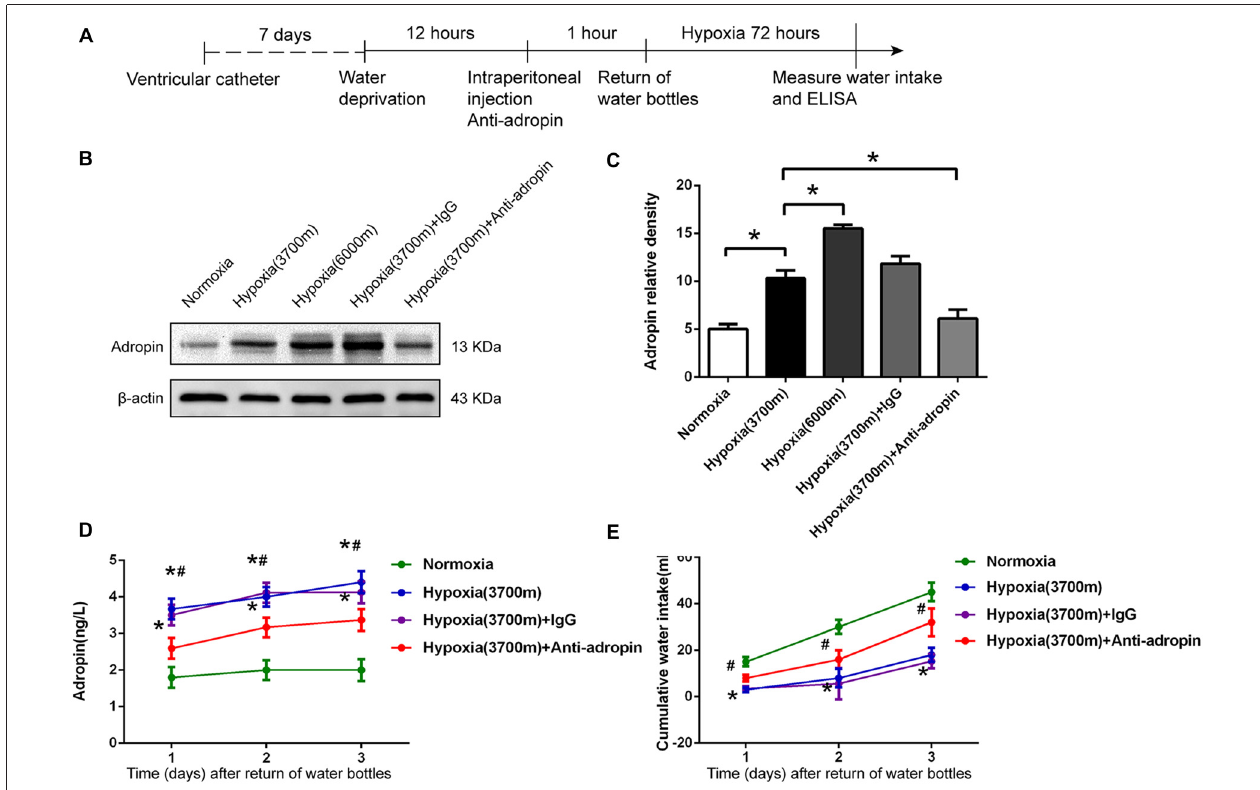
FIGURE 1 | Anti-dipsogenic effects were related to increased adropin under hypoxia in rats. (A) The experimental design to study the mechanism of central anti-dipsogenic effects ( Figures 1 , 2 ). (B) Adropin protein in circumventricular organs (CVOs) nuclei was down-regulated 25 h after injection of 10 µ l adropin antibody into the third ventricle after overnight water deprivation-induced drinking in rats. (C) Relative protein expression was calculated ( n = 6 for each group, ∗ P < 0.05). (D) The expression of serum adropin was enhanced under hypoxia (3700 m and 6000 m) at 1, 2 and 3 days after overnight water deprivation-induced drinking in rats ( n = 8 for each group; ∗ P < 0.05 vs. normoxia group; # P < 0.05 vs. 3700 m hypoxia group). (E) Hypoxia induced anti-dipsogenic effects was alleviated after administration of 10 µ l rat source special adropin antibody under hypoxia (3700 m) after overnight water deprivation-induced drinking in rats (IgG as a control, n = 8 for each group; ∗ P < 0.05 vs. normoxia group; # P < 0.05 vs. 3700 m hypoxia